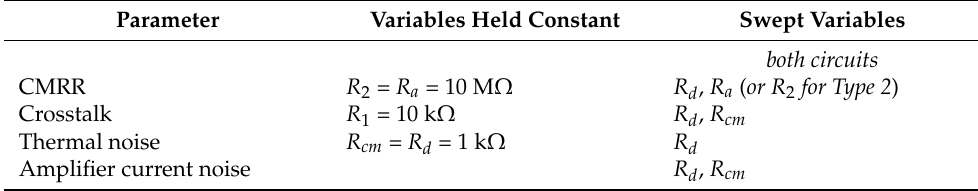
Table 6. Variables chosen for